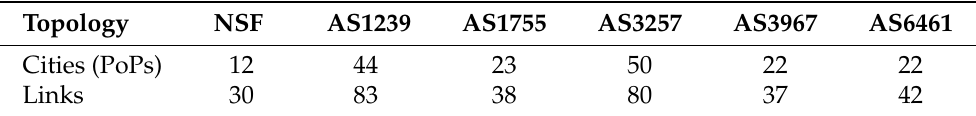
Table 3. Network topologies used in the evaluations. The table lists the number cities and inter-city links, which we refer to as